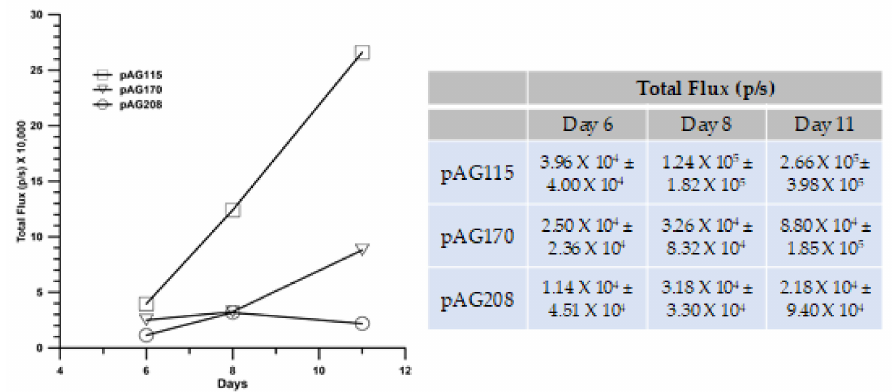
Figure 7. IL-15 / IL-15R α GET protects mice from secondary tumor formation in a lung colonization model. B16.F10 tumors were induced on the flanks of C57BL / 6 Albino mice and treated with GET using the EP2 protocol on days 0, 4, and 7. On the day of first treatment, B16.F10-Luc G5 cells were injected intravenously. Tumor metastasis was monitored using an IVIS spectrum and reported as luminescence (photons / sec). n = 9 for each